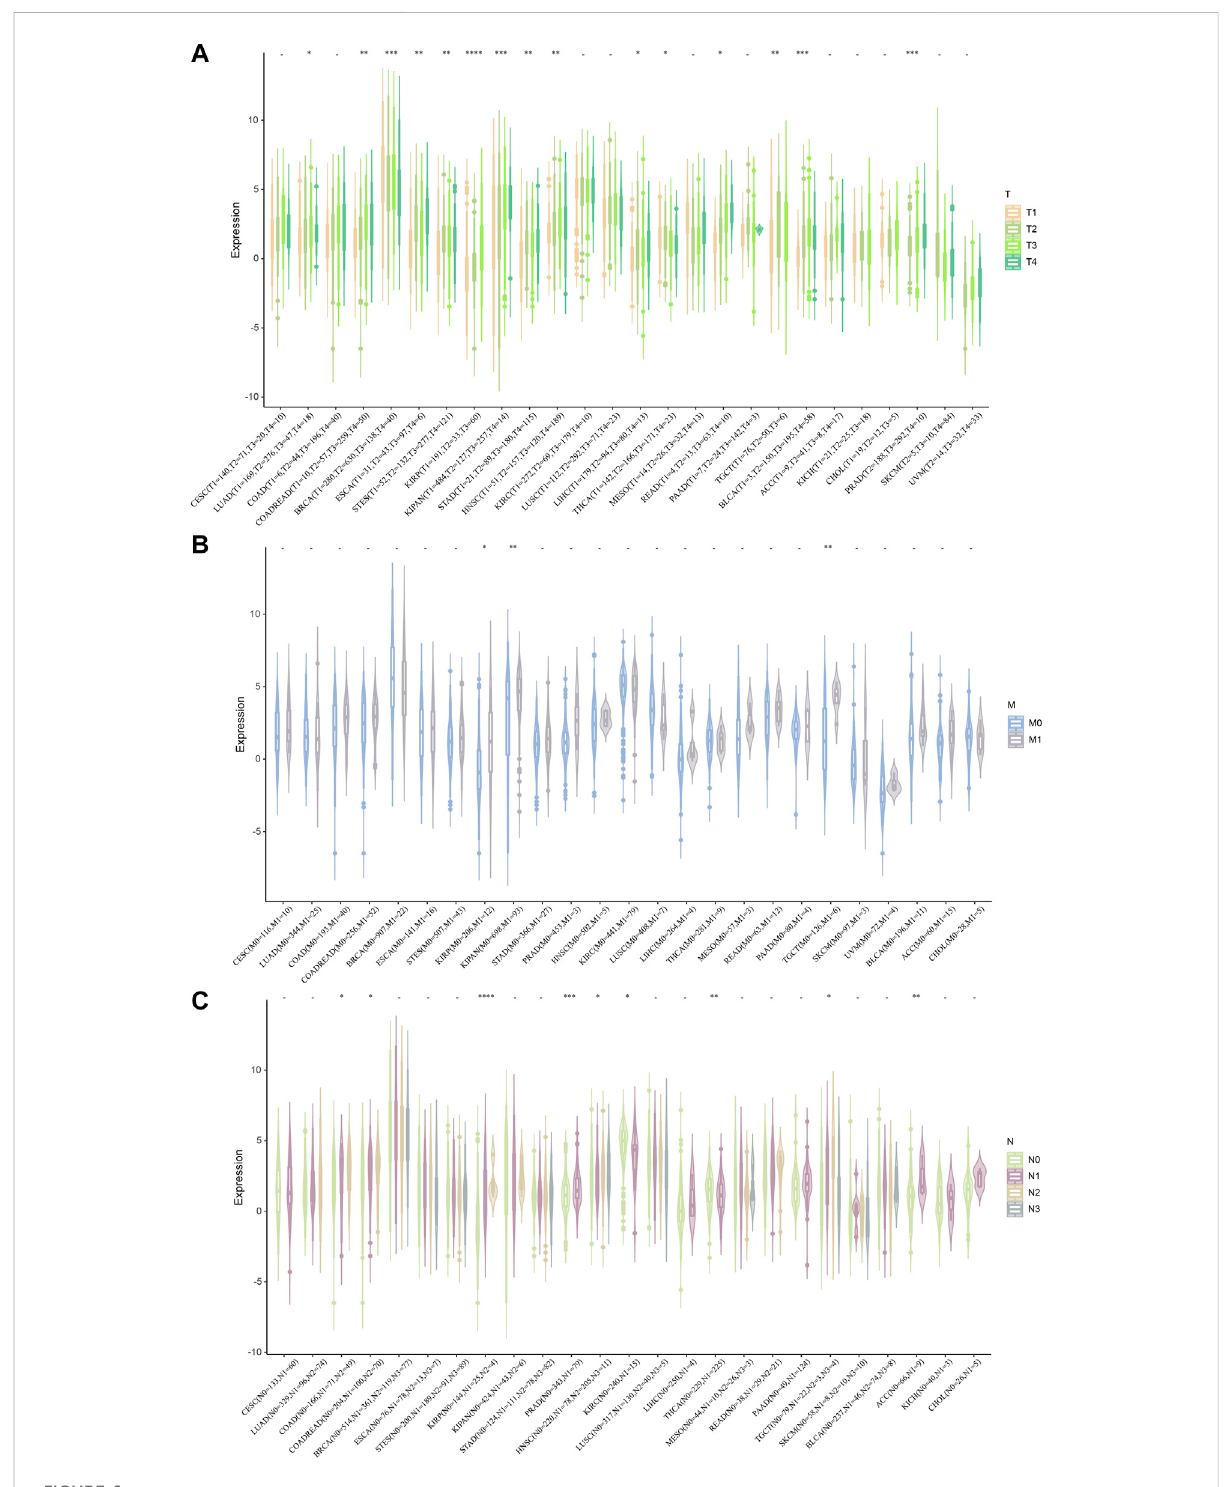
FIGURE 6 Correlation between STC2 Expression and Clinical phenotypes. (A – C) The relationship between STC2 expression and TMN staging. *: p -value < 0.05; **: p -value < 0.01, ***: p -value < 0.001, ****: p -value <